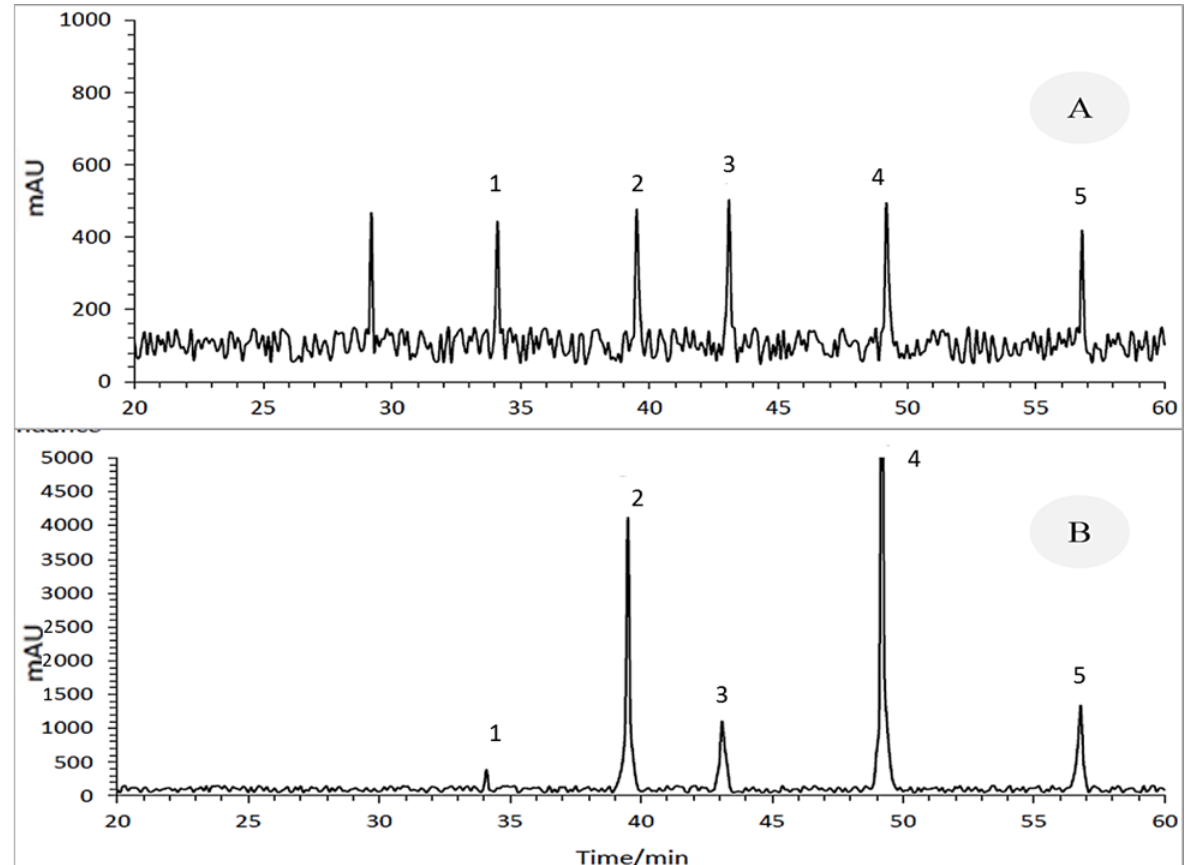
Figure 3. HPLC representative chromatogram of ( A ) the standard extracts and ( B ) seed extracts of Cuscuta campestris developed on various hosts. 1. Brassicasterol (retention time: 34.1 min); 2. Campesterol (retention time: 39.5 min); 3. Stigmasterol (retention time: 43.09 min); 4. β -Sitosterol (retention time: 49.2 min); 5. ∆ 7 -Avenasterol (retention time: 56.8